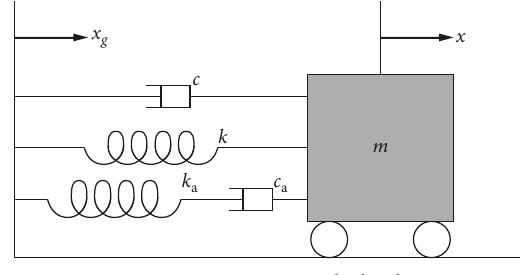
Figure 1: SDOF system with the